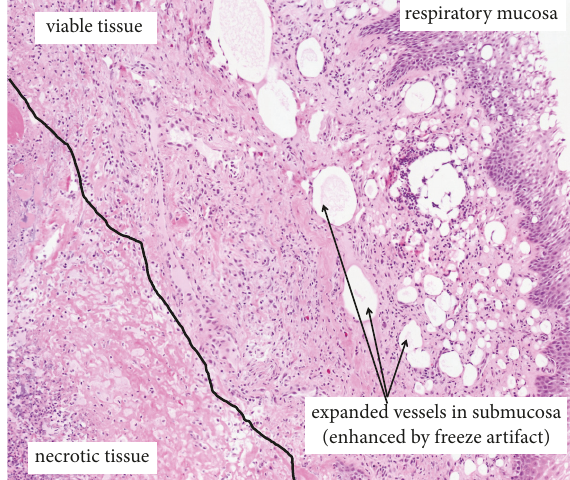
Figure 6: Histological observations from safety phase soft palates. There were moderate-to-extensive regions of tissue disruption and patchy necrosis with mild-to-moderate inflammatory and fibroplastic responses in viable tissue in both treated and untreated regions of the soft palate, believed to be due to the consistently observed excessive expansion of the soft palate (pillowing) during the injections.